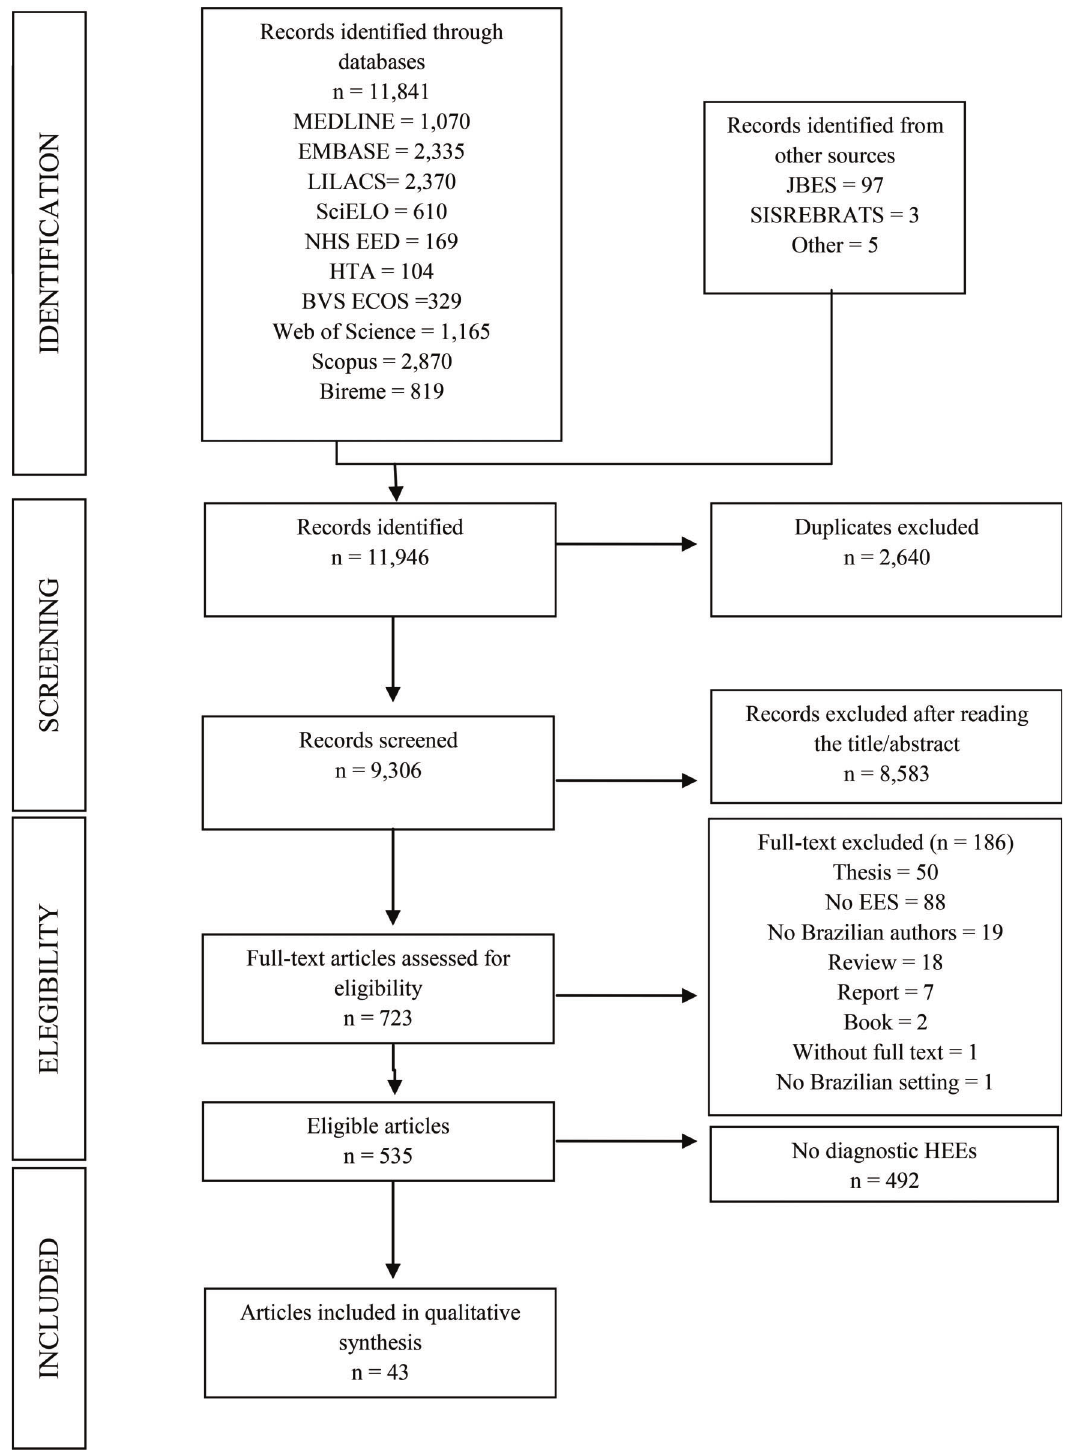
Figure 1 - Flow diagram of the process used to select HEEs related to diagnostic tests in Brazil, 1983-2013. *HEEs: health economic